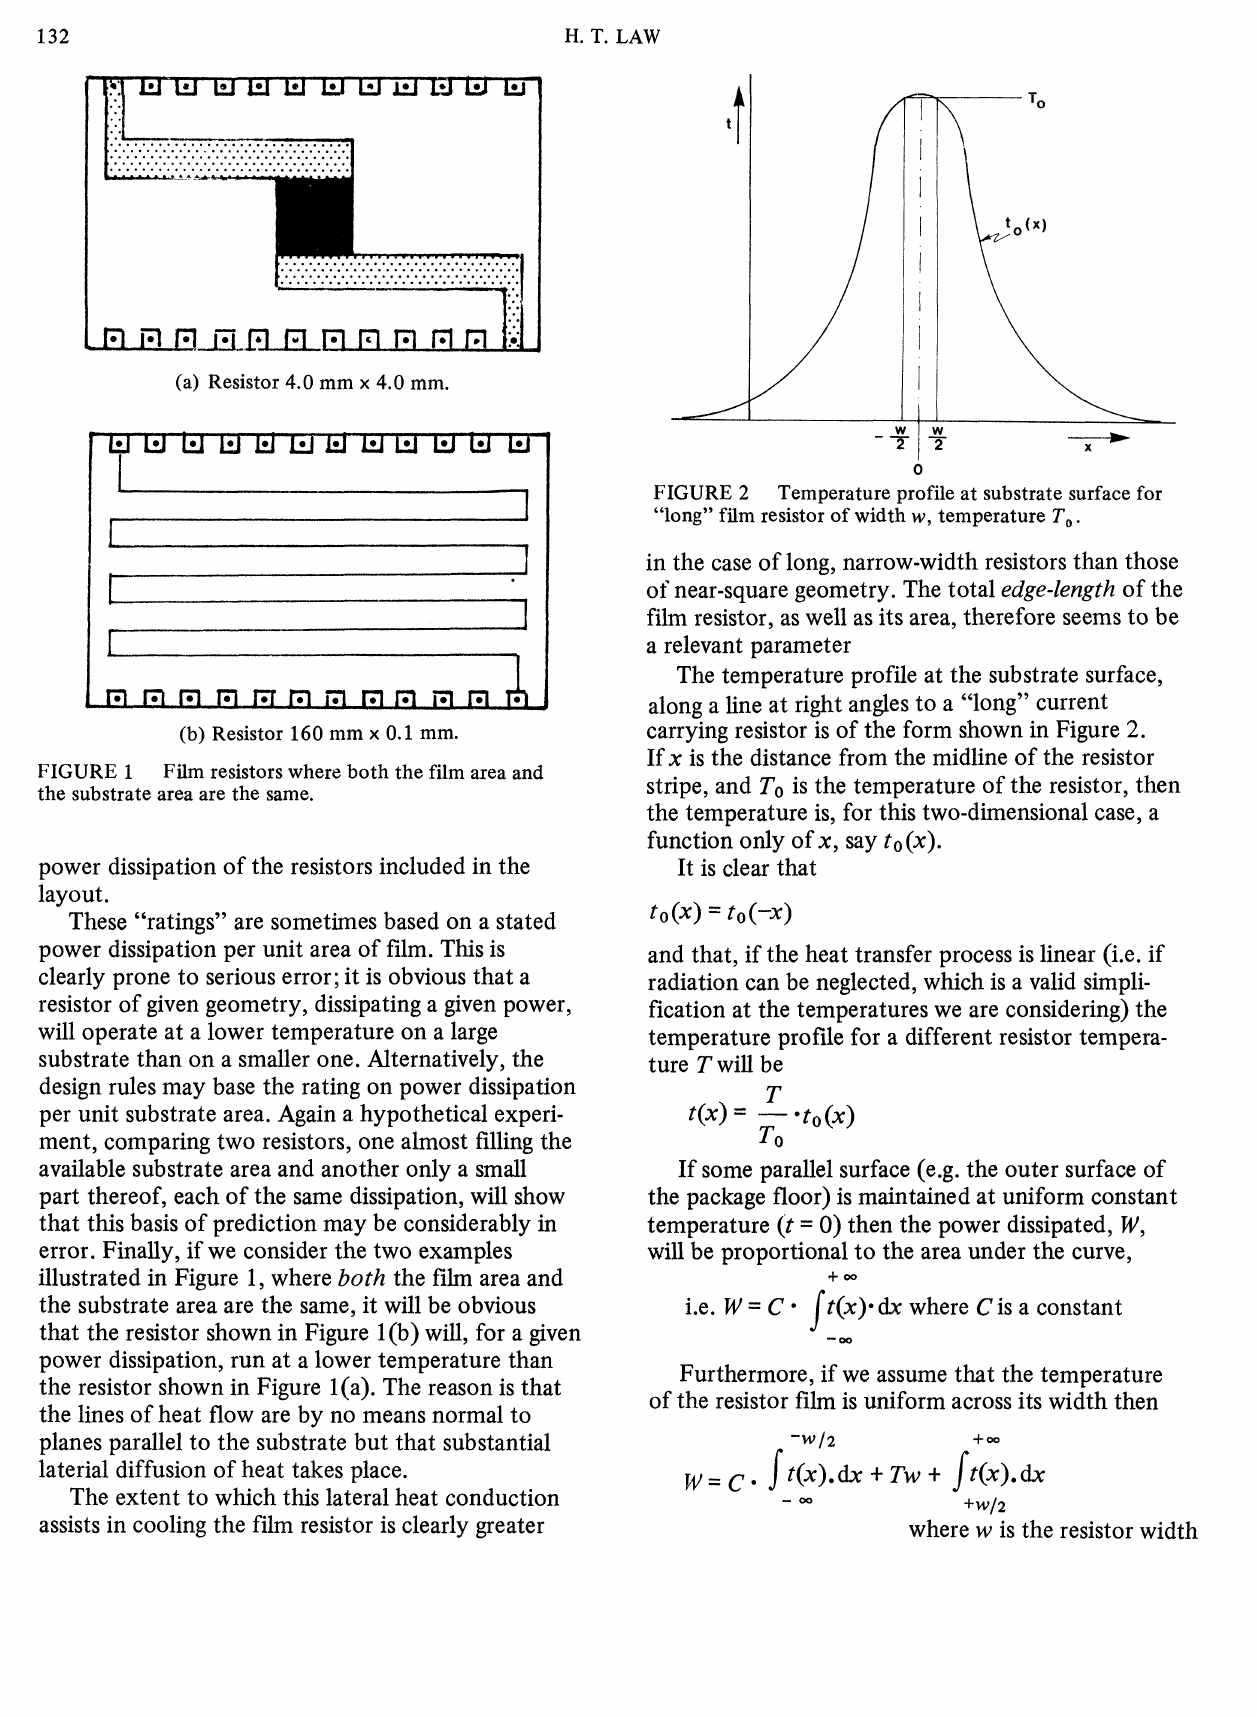
Temperature profile at substrate surface for "long" film resistor of width w, temperature T in the case of long, narrow-width resistors than those of near-square geometry. The total edge-length of the film resistor, as well as its area, therefore seems to be a relevant parameter The temperature profile at the substrate surface, along a line at right angles to a "long" current carrying resistor is of the form shown in Figure 2. If x is the distance from the midline of the resistor stripe, and To is the temperature of the resistor, then the temperature is, for this two-dimensional case, a function only of x, say